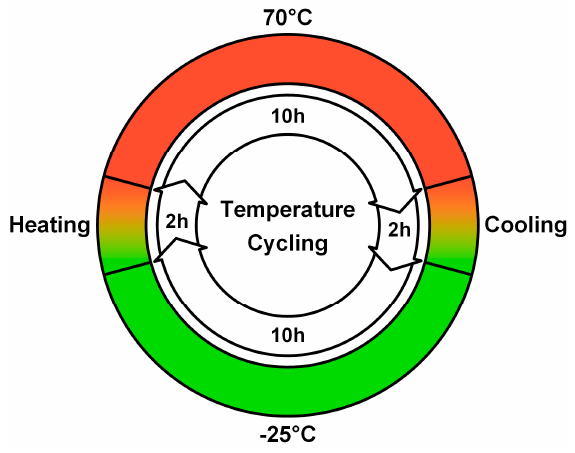
Figure 2. Diagram of a temperature cycle.